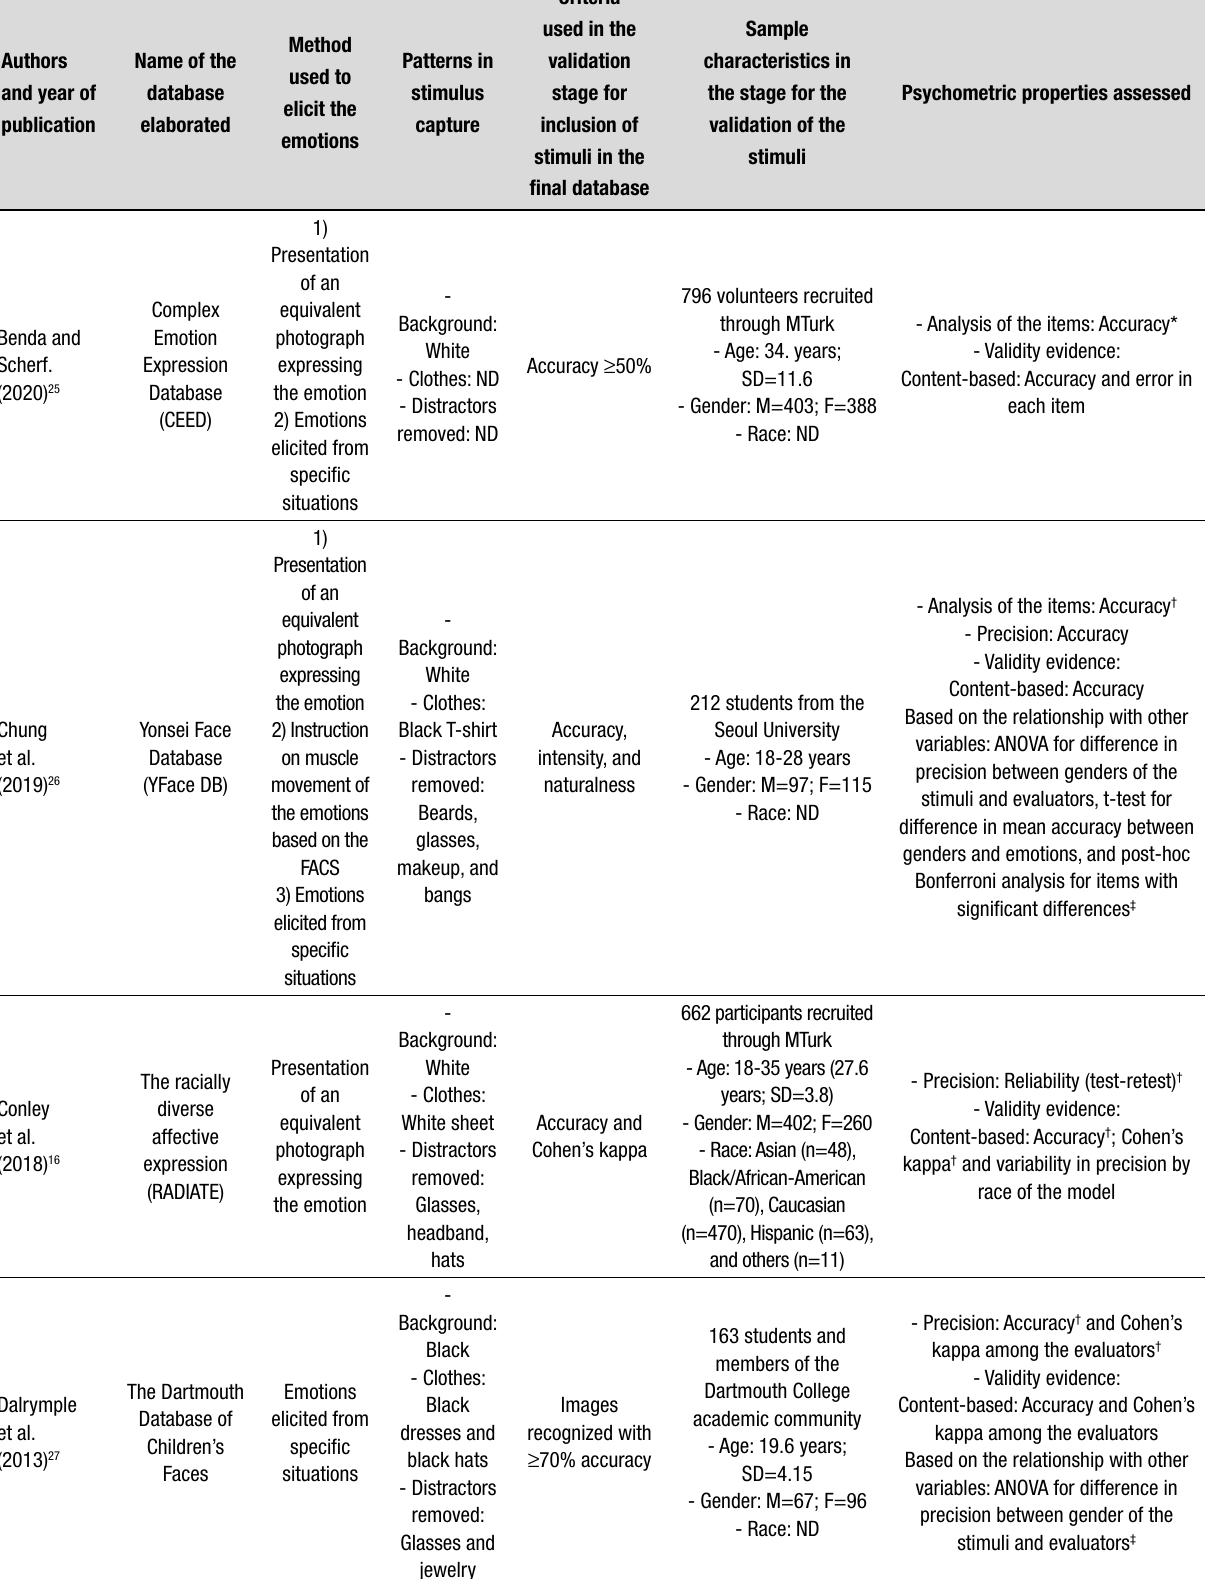
precision between gender of the stimuli and evaluators ‡